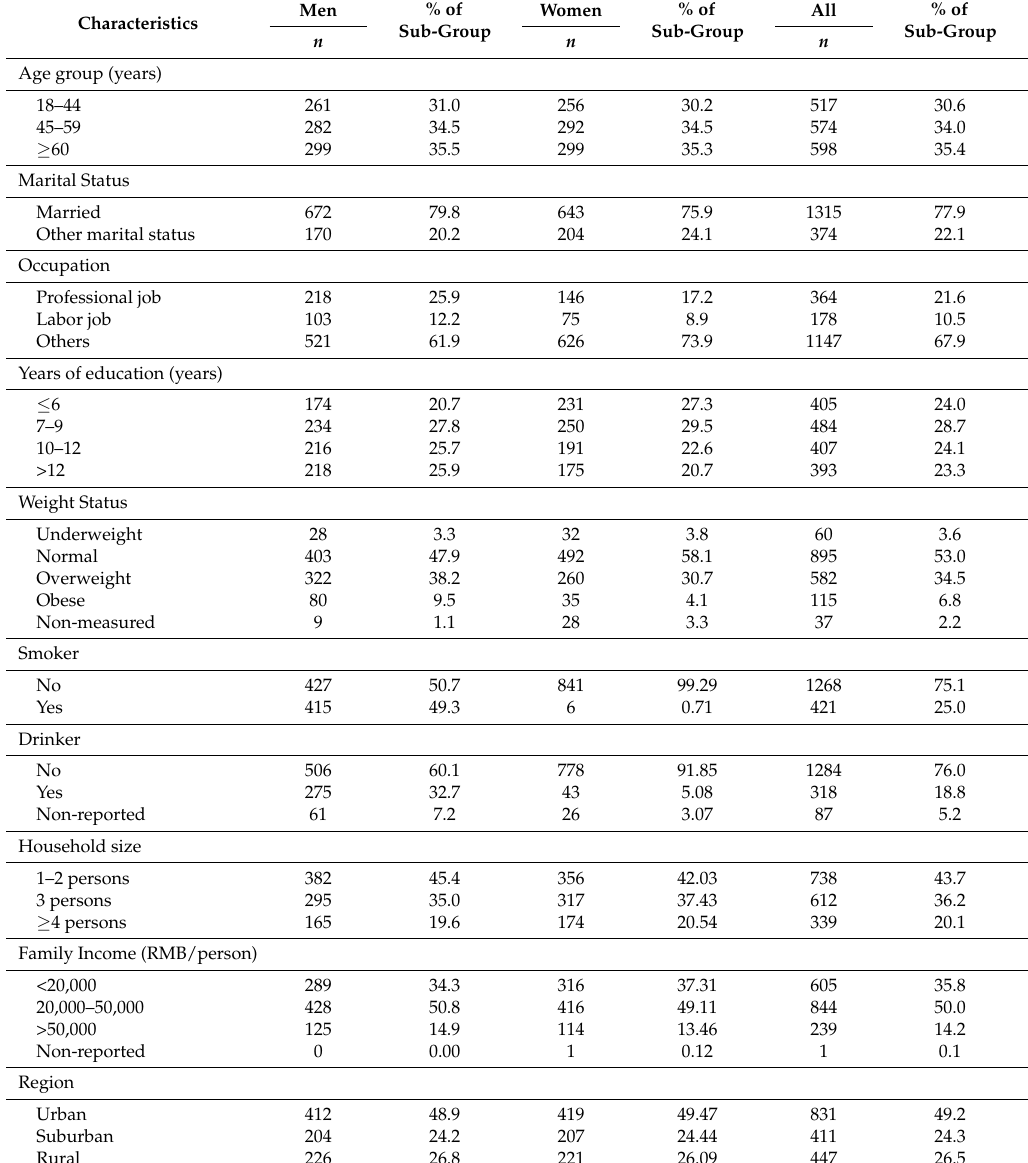
Table 1. Characteristics of study